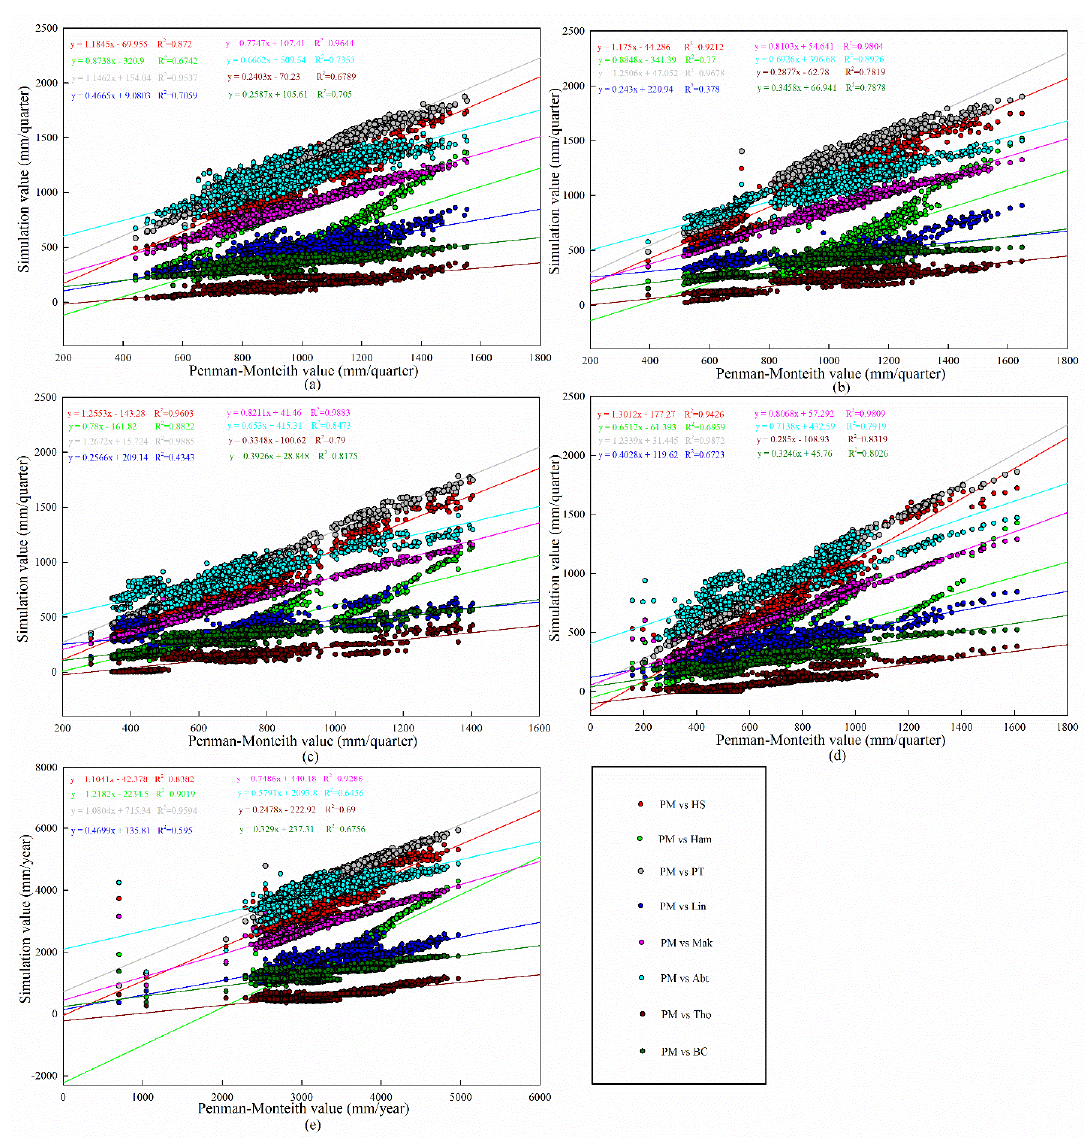
Figure 5. Linear regression of measured and simulation values in the arid river valley region: ( a ) spring; ( b ) summer; ( c ) autumn; ( d ) winter; and ( e ) annual.